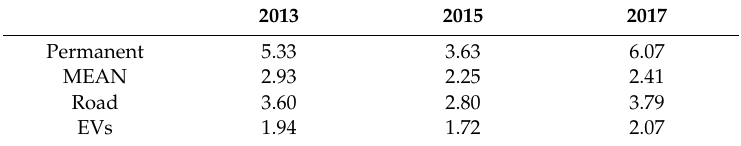
Table 7. The VIF values for the eigenvector spatial filtering (ESF) regression